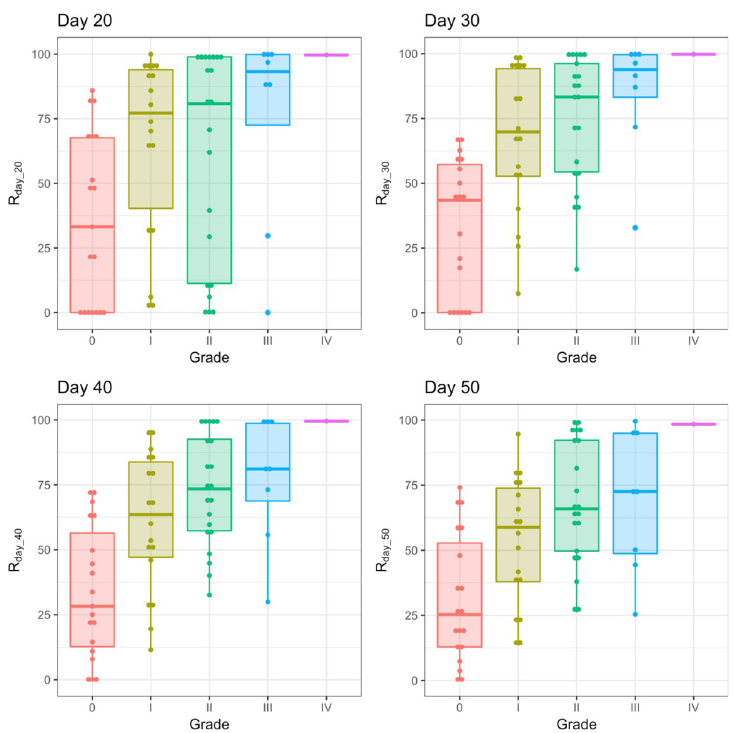
Table 3. Comparison of data fitting between two models using Akaike’s information criterion. Model with 2 types of sDNAM-1: no. of patients (%) GVHD (–) GVHD (+) Total 0.0013 ( <